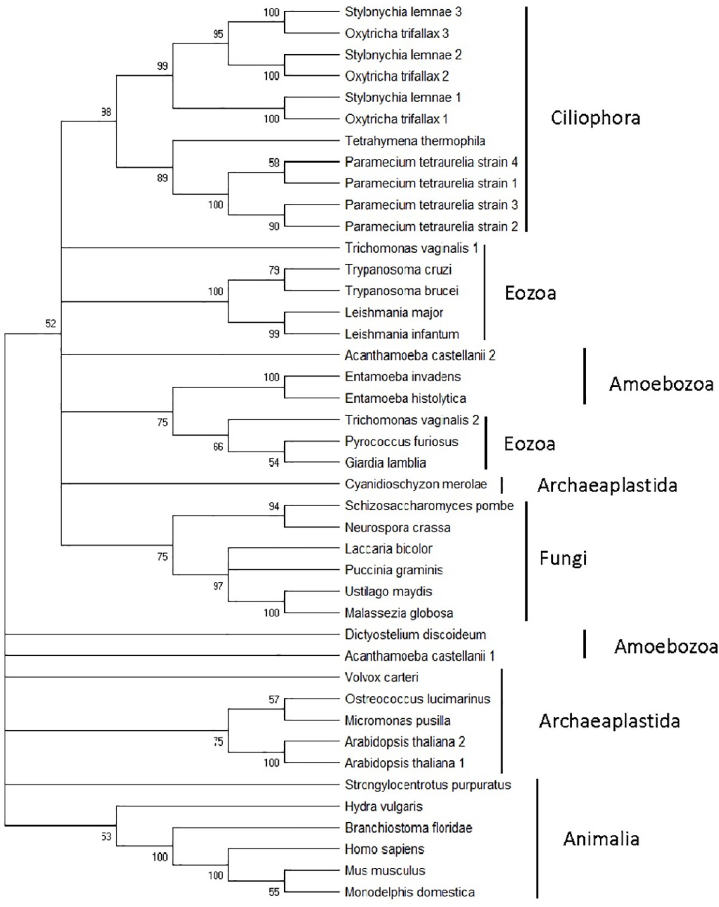
Fig 3. Phylogenetic maximum likelihood tree drawn for PCNA of 31 different eukaryotic species. Both domains of PCNA were used for alignment. Species from 6 kingdoms of eukaryotes—animalia, fungi, archaeplastida, amoebozoa, eozoa and ciliophora (inside the kingdom chromista)—were used to draw the tree. The purpose of using organisms from 6 different kingdoms is to represent the entire eukaryotic domain, not just the crown groups. This tree demonstrates that most species contain only one PCNA that is vertically inherited. The instances where there is gene duplication and horizontal gene transfer is indicated in the